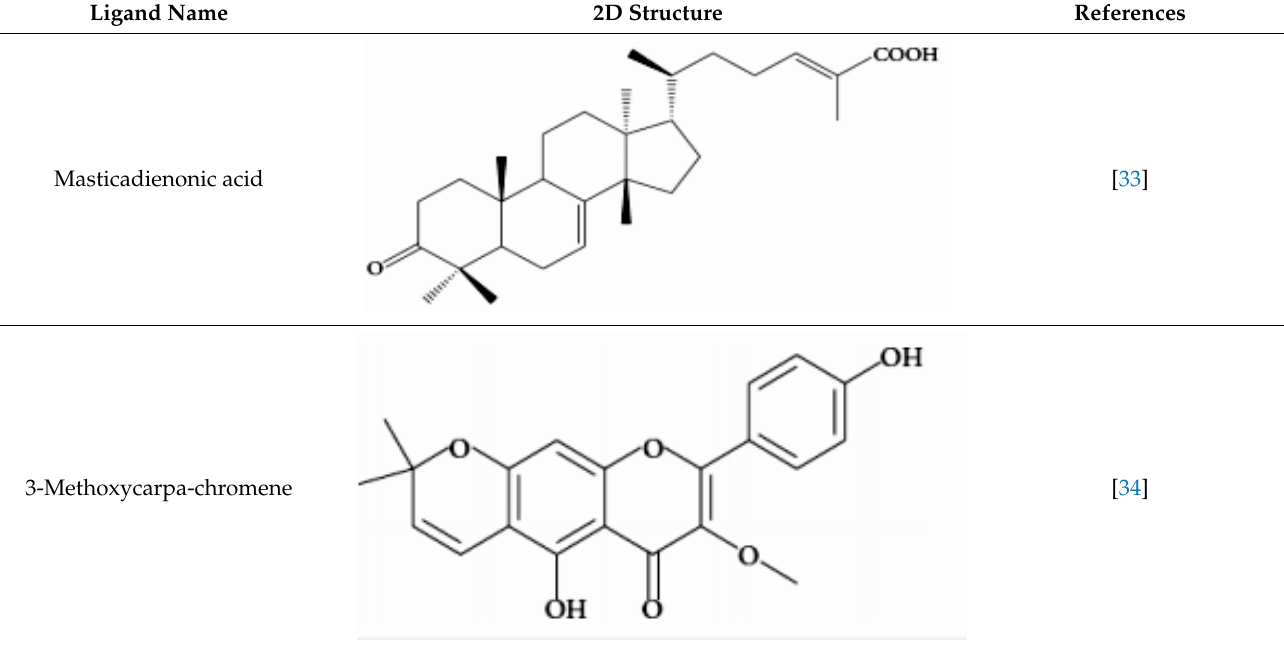
Table 2. The selected ligands of the chemical ingredients of P. atlantica cited in the literature. Ligand